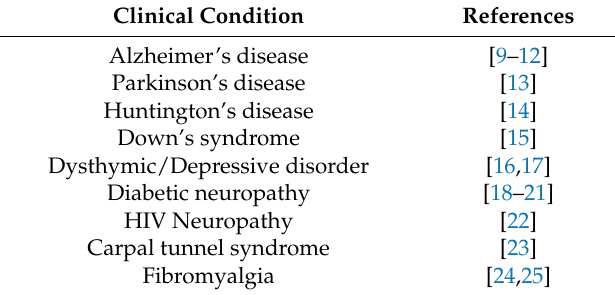
Table 1. L -Acetylcarnitine (LAC) clinical studies for disorders of central and peripheral nervous system.